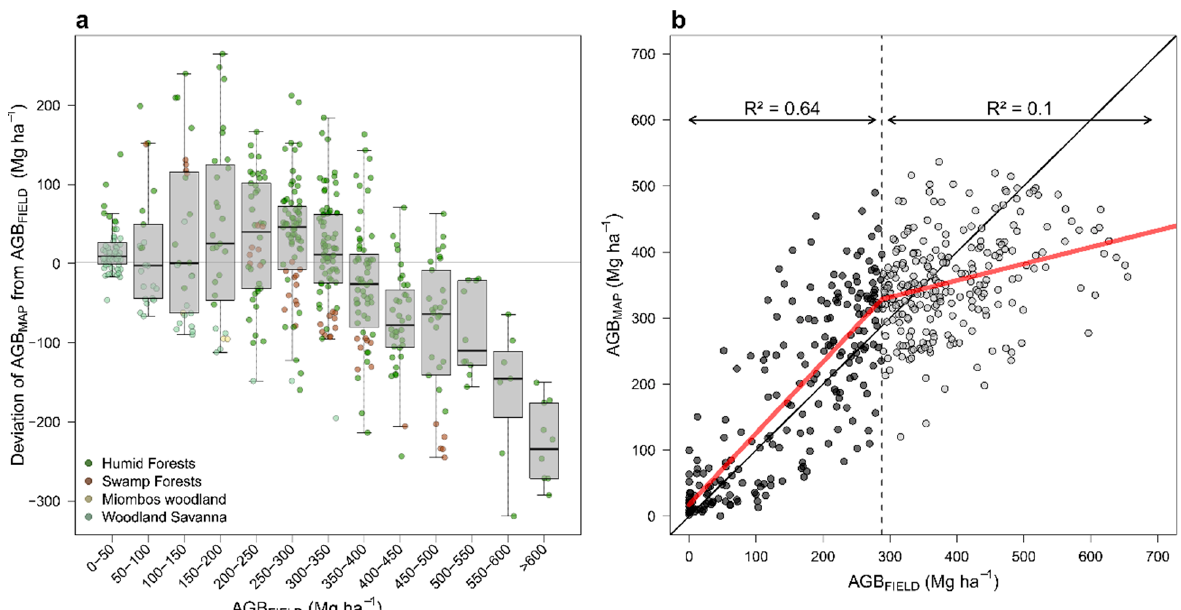
Figure 4. ( a ) Breakdown of mapping error by classes of aboveground biomass derived from inventory data ( AGB FIELD ). ( b ) Breakpoint in the relationship between sample plots’ aboveground biomass derived from the biomass map ( AGB MAP ) and AGB FIELD . The red line represents the fit of a piecewise regression. The dashed vertical line highlights the location of the breakpoint.